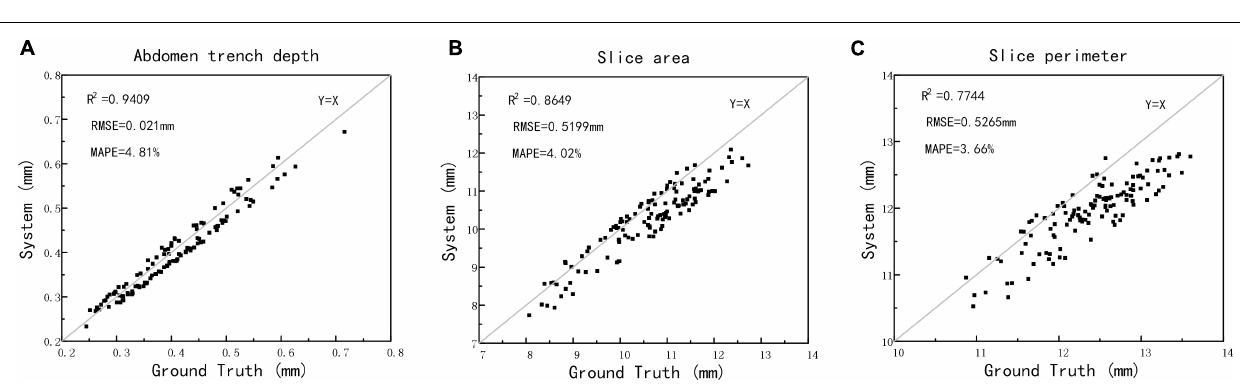
FIGURE 8 | The automatic measurements versus manual measurements of wheat ventral sulcus traits. (A) Ventral sulcus depth. (B) Slice area. (C) Slice